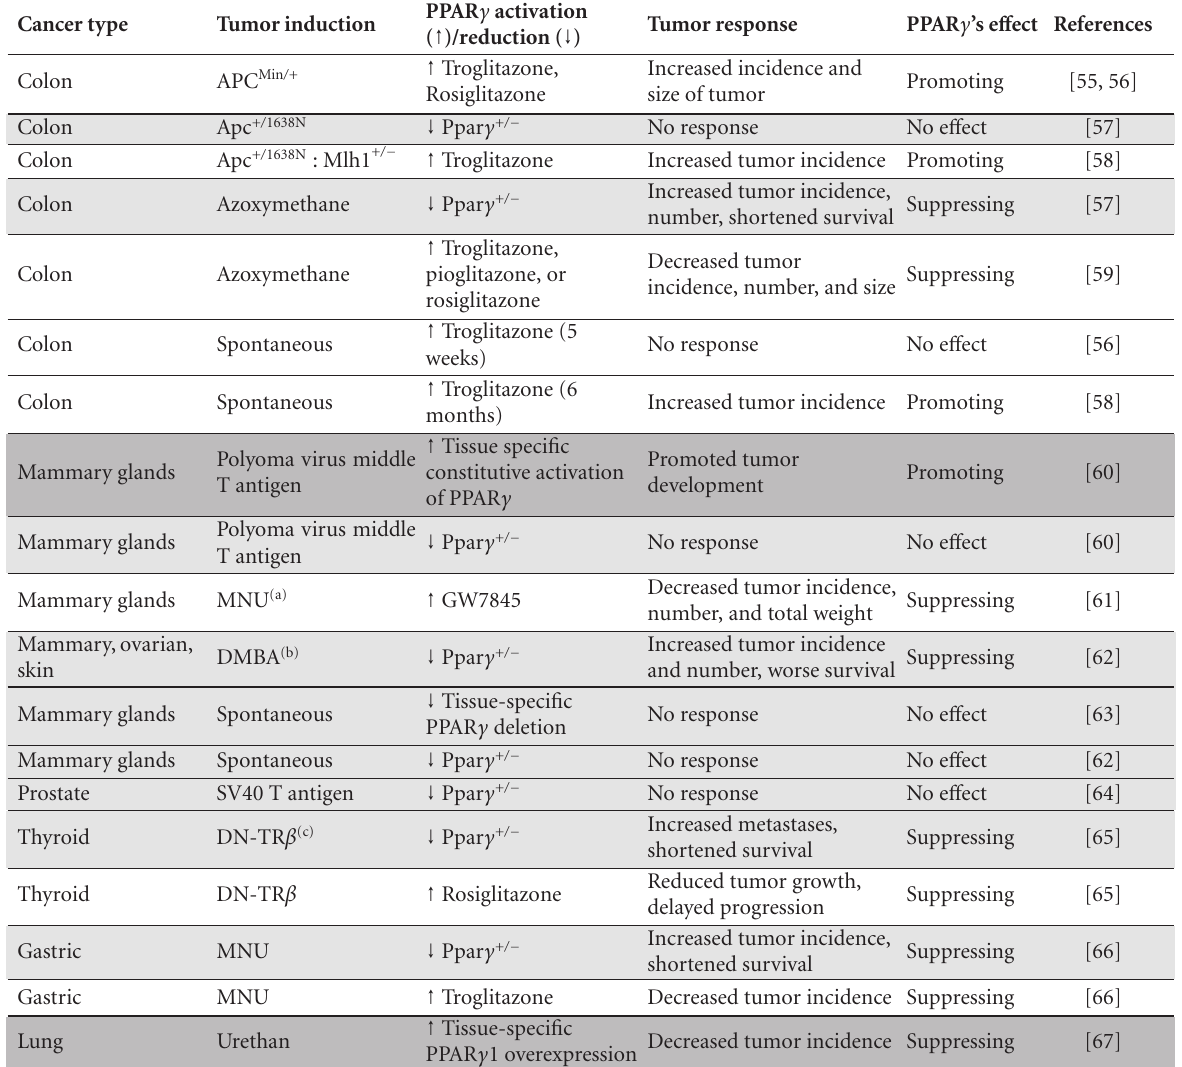
Table 6: PPAR γ and agonists in animal models (di ff erentially shaded according to methods of PPAR γ manipulation).